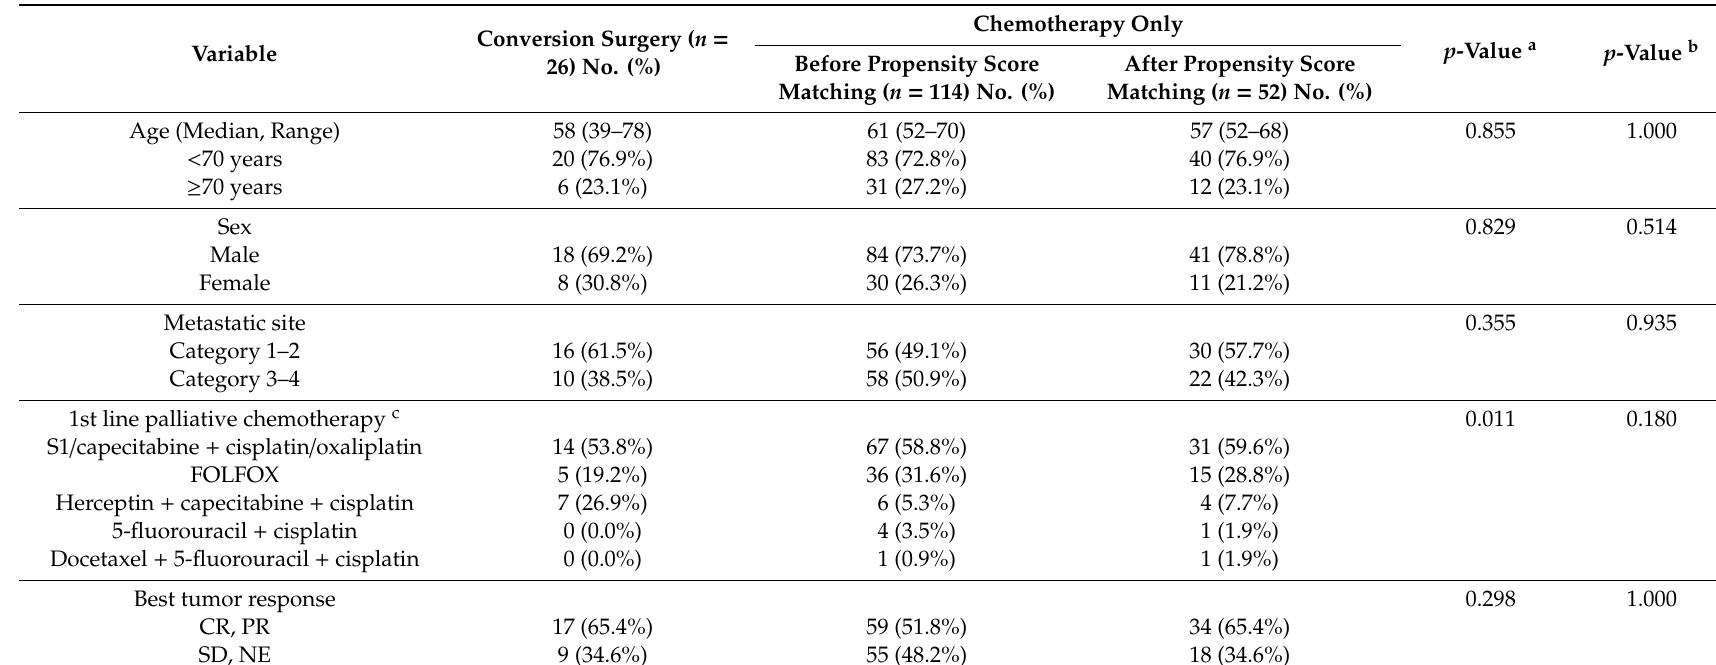
Table 1. Demographics and baseline characteristics of